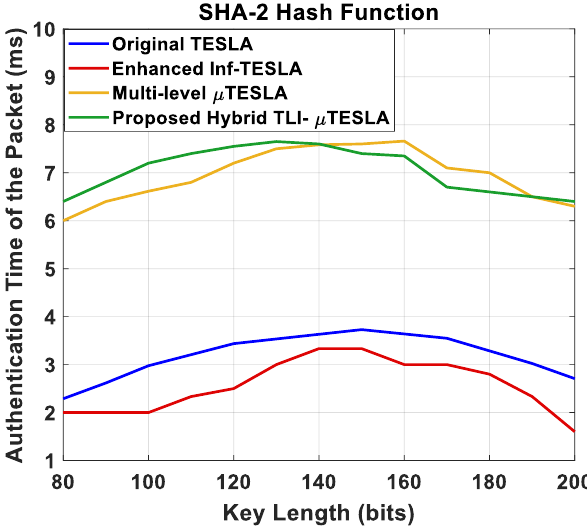
Figure 8. Simulation results of the original TESLA protocol (blue line), enhanced Inf-TESLA protocol (red line), Multilevel-µTESLA protocol (yellow line), and Proposed Hybrid TLI-µTESLA protocol (green line), demonstrating the computational overhead at the receiver side during the authentication time of the received packets with the change in the key size using SHA-2 hash function.